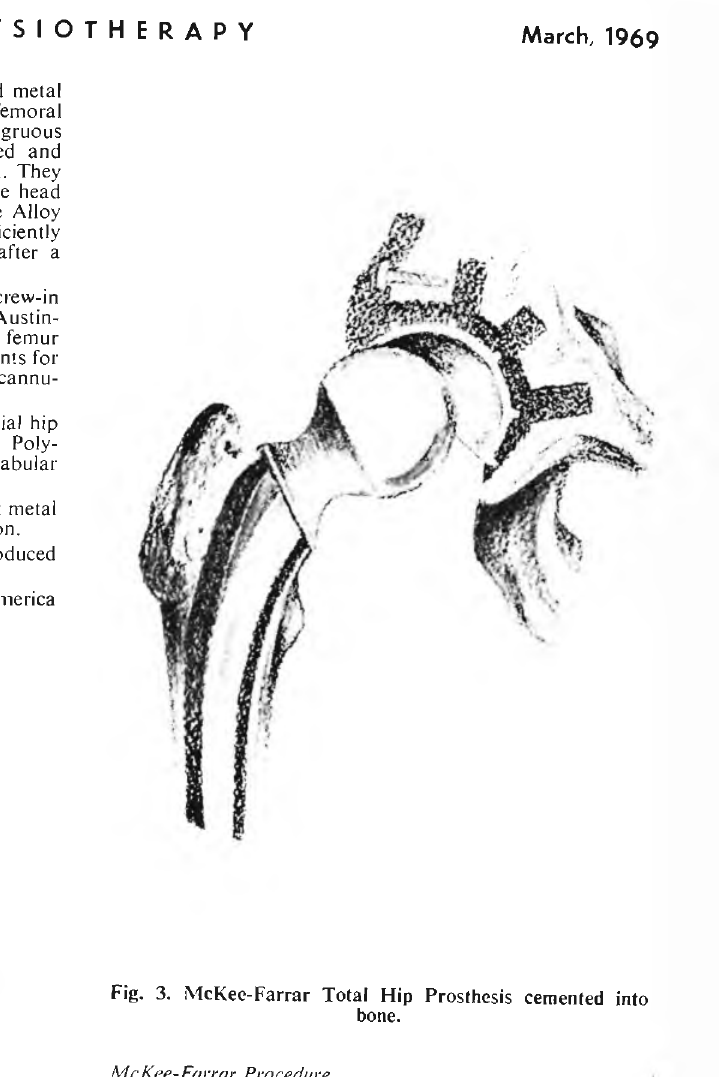
Fig. 3. McKee-Farrar Total Hip Prosthesis cemented into bone.